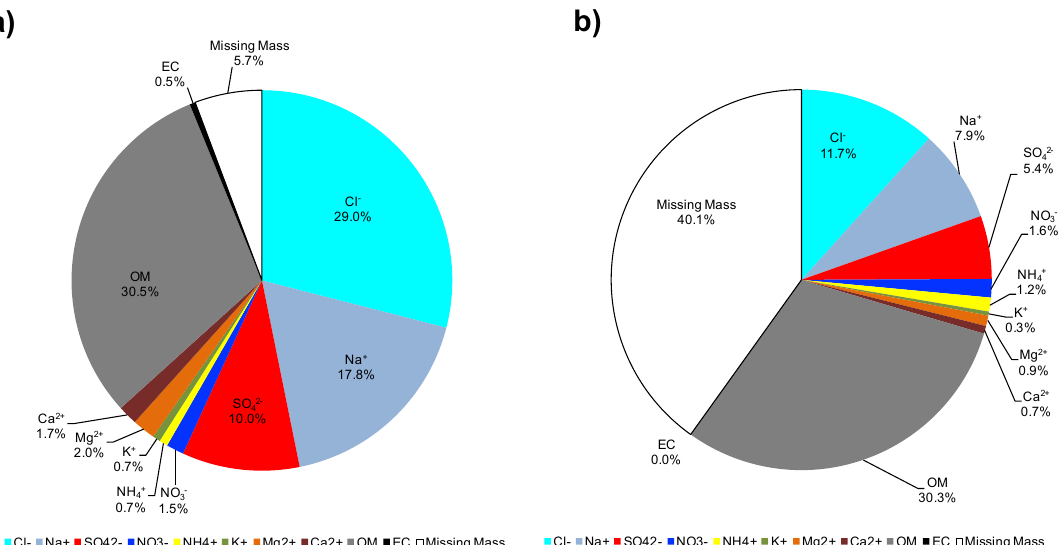
Figure 8. Relative contributions (percentages) of the major constituents of the aerosol samples collected: ( a ) along the cruise, and ( b ) in Ny-Ålesund. Missing mass indicates the aerosol mass fraction not explained by the chemical components that were analyzed.